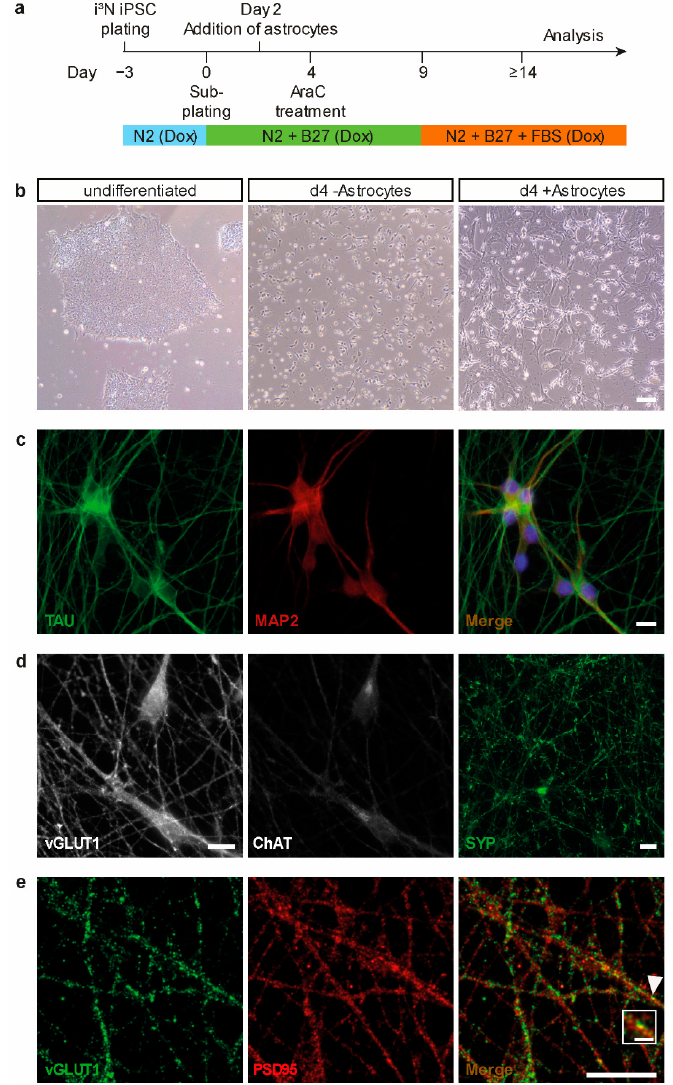
Figure 1. Differentiation and characterization of human induced pluripotent stem cell (iPSC)-derived cortical neurons. ( a ) Schematic representation of human iPSC differentiation protocol using doxycycline and coculturing of primary murine astrocytes. ( b ) Representative phase-contrast images at indicated time points of human iPSC differentiation into cortical neurons with and without coculturing of astrocytes; scale bar = 100 µm. ( c – e ) Representative images of iPSC-derived neurons 14 days after initiation of differentiation indicate proper neuronal maturation into glutamatergic neurons, and formation of axons, dendrites and synapses. ( c ) Immunocytochemical stainings of neuronal marker expression (TAU, MAP2) show the expected polarized distribution of predominantly axonal TAU (left panel) and predominantly dendritic MAP2 protein (middle panel). The merge includes nuclear stain NucBlue to indicate somata (right panel); scale bar = 10 µ m. ( d ) Immunocytochemical stainings for neuronal differentiation markers. Neurons express glutamate transporter 1 (vGLUT1; left panel) but lack the expression of the motor neuron marker choline acetyltransferase (ChAT; middle panel). Neurons express the presynaptic marker synaptophysin (SYP; right panel); scale bars = 10 µ m. ( e ) Immunocytochemical stainings for neuronal synaptic markers. Neurons form synapses, as visualized by expression and co-localization of the signals obtained with antibodies directed against the presynaptic marker vGLUT1 (left panel) and the postsynaptic marker PSD95 (middle panel); white arrowhead in the merge-image (right panel) indicates an example of a mature synapse, which is magnified in the white squared box; scale bar = 10 µ m, scale bar of magnification = 1.5 µ